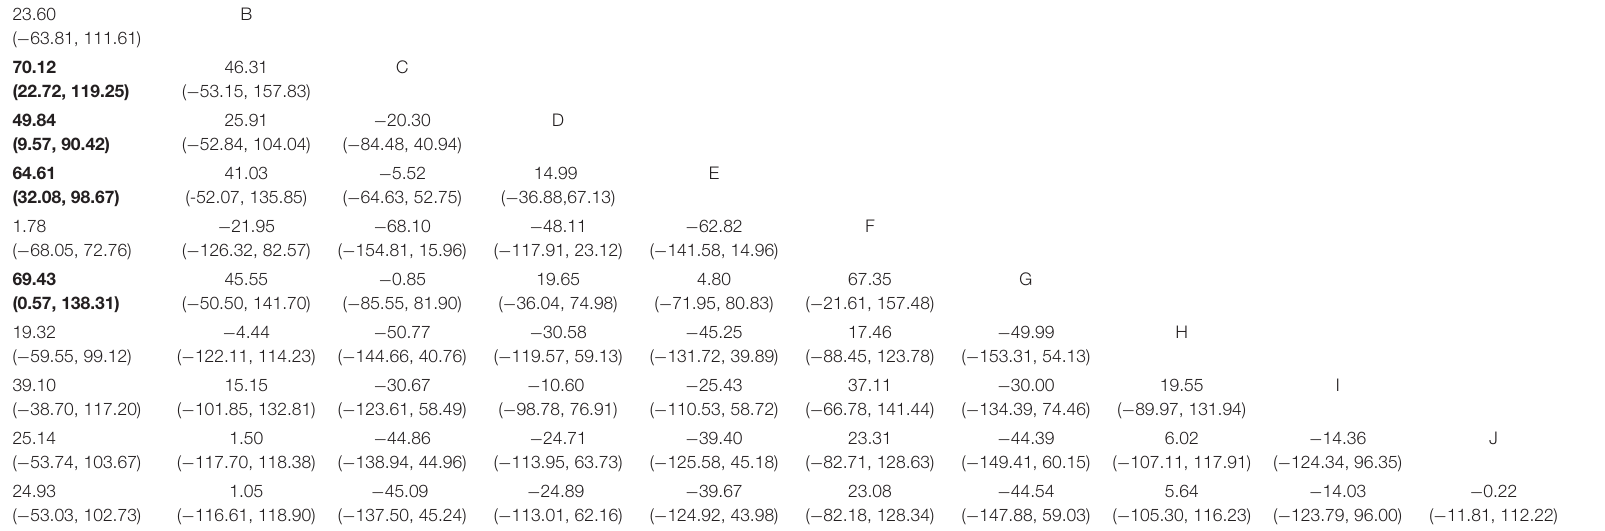
TABLE 3 | League table of all RUV comparisons. A 23.60 ( − 63.81,